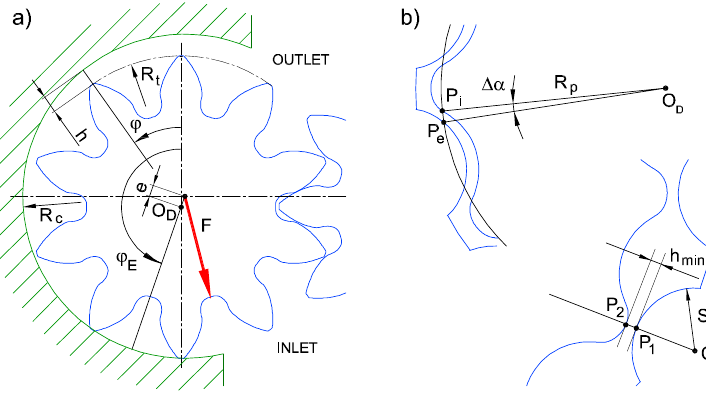
Figure 17. Variable height profile on the tooth tip: ( a ) in external gear machines; ( b ) in gerotor pumps.